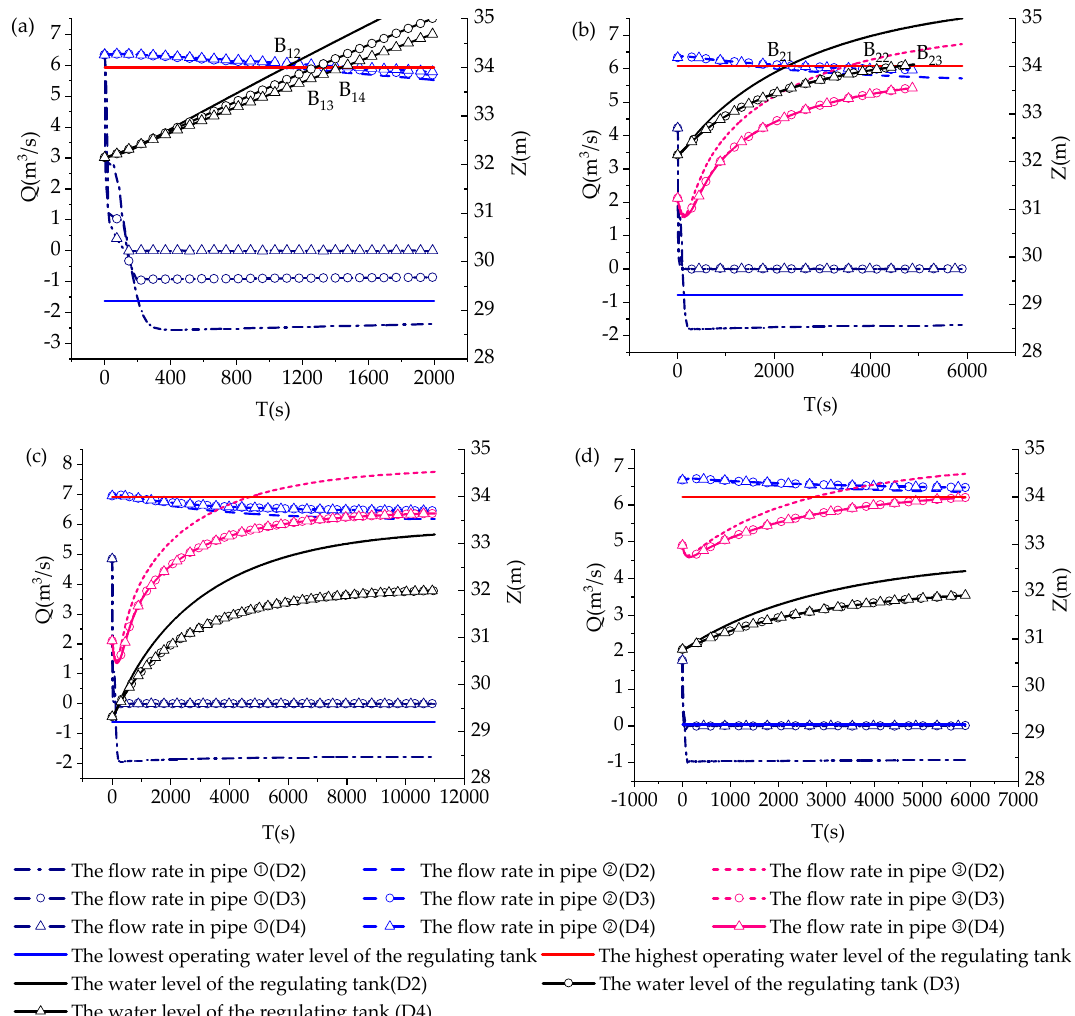
Figure 6. ( a – d ) Transient processes of scheme OS1-C1, OS2-C1, OS2-C2, OS3-C1 under D2–D4.